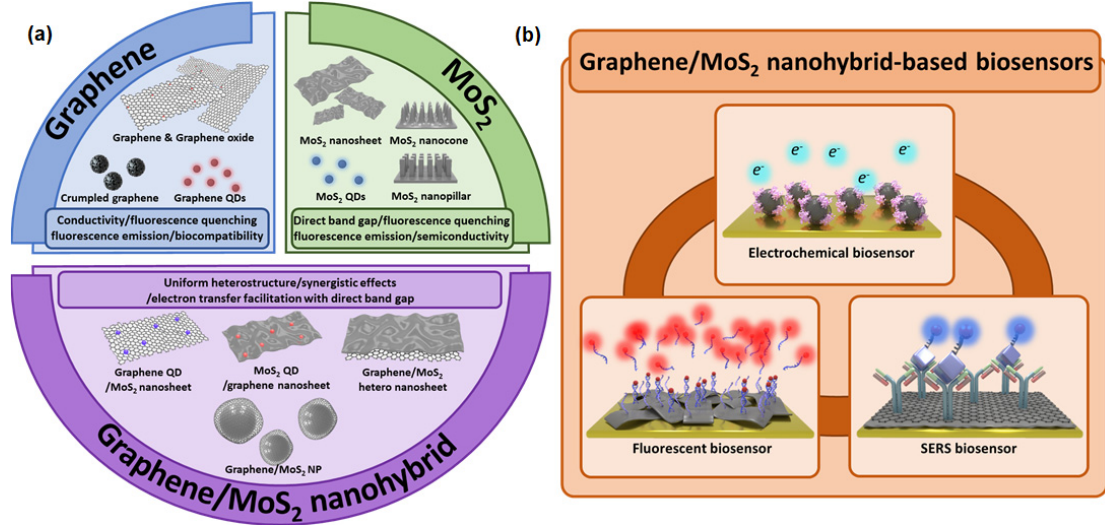
Figure 1. ( a ) Characteristics of graphene, molybdenum disulfide (MoS 2 ), and graphene/MoS 2 nanohybrid, and ( b ) their utilization to develop graphene/MoS 2 nanohybrid-based biosensors.